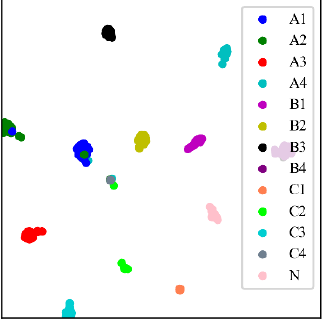
Table 9. The results of the testing dataset in different models (%).